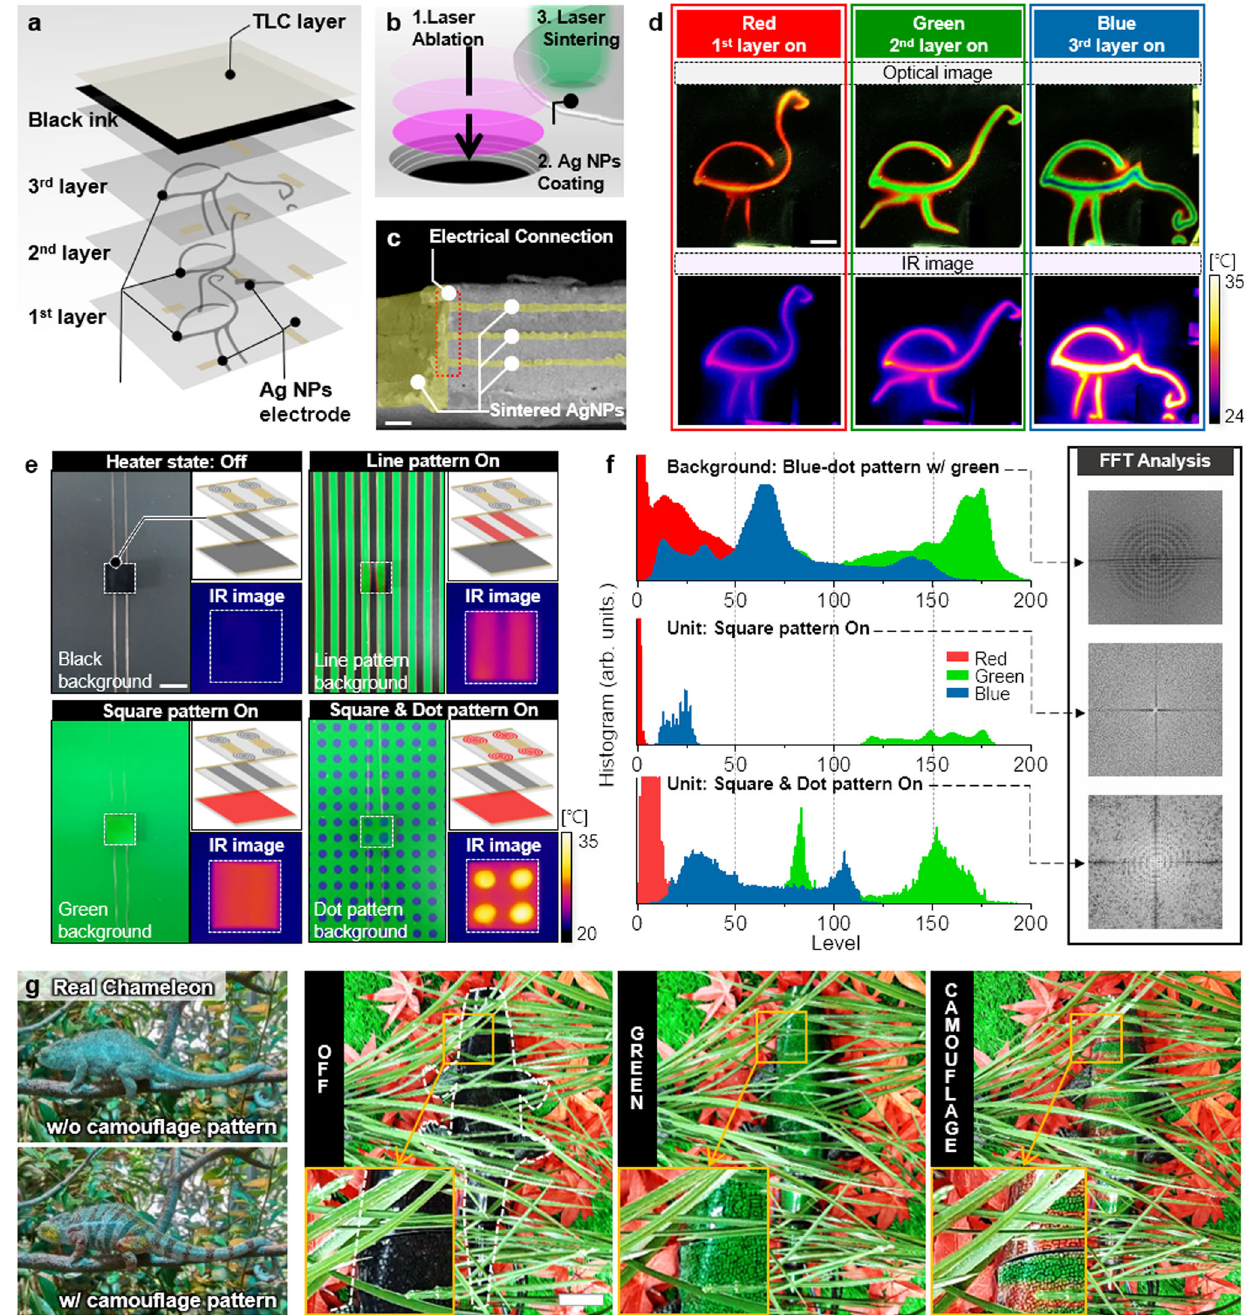
Fig. 3 The ATACS with a multi-layered heater for effective camou fl age in microhabitat. a Schematics of the ATACS with multi-layered 3 ostrich patterns. b A laser-assisted fabrication process for stacking heater layer. c SEM image of the ATACS ’ s cross-section. The electrical connection between sintered Ag NPs electrodes is successively formed. The scale bar is 10 µ m. d Digital and IR image of colorful running ostrich demonstration. The scale bar is 5 mm. e Concealment of the multi-layered ATACS from the background by color and pattern matching. Inset IR images show the heater state corresponds to pattern and color. The scale bar is 15 mm. f Color and pattern similarity analysis: RGB histogram from digital images of blue-dot pattern with a green background, the ATACS with green square pattern, the ATACS with a green square, and blue-dot pattern. g Effectiveness of camou fl age pattern for crypsis. Visual comparison of a real chameleon and chameleon model covered with 7 multi-layered ATACS. The scale bar is 5